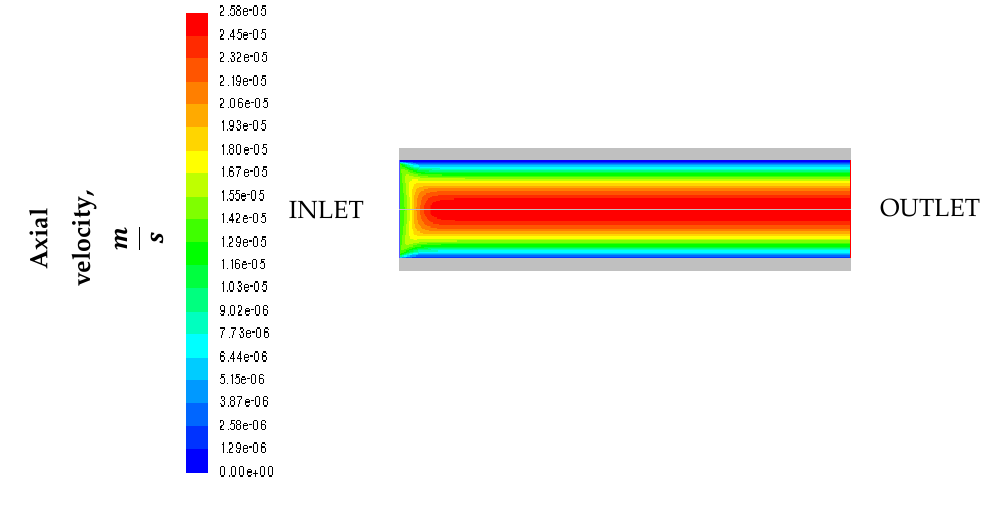
Figure 4. Trend of the axial velocity.